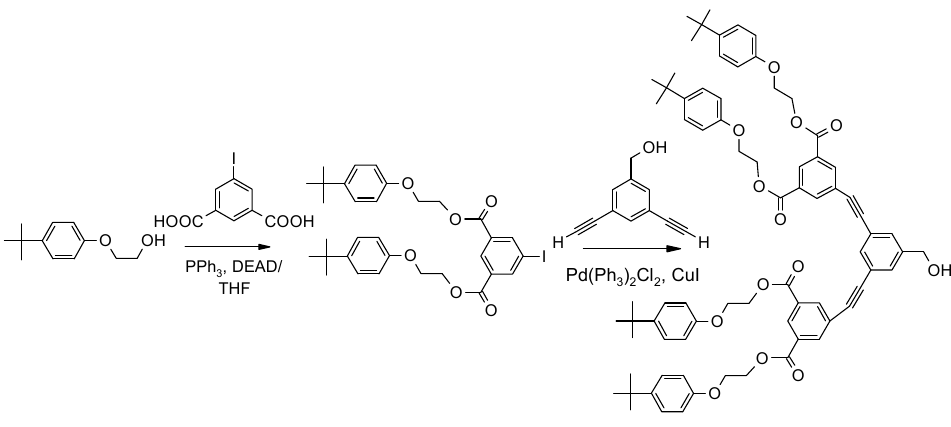
Scheme 4. Formation of the dendron for an alternating polyester dendrimer [102].